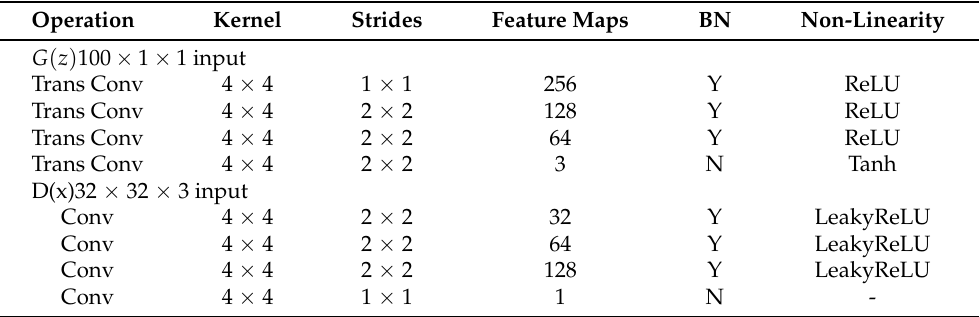
Table 2. GAN hyperparameters. The learning rates for the generator and discriminator are both equal to the same value, across all cases. BN stands for batch normalization, and Trans Conv stands for transpose convolution, Conv means convolution.